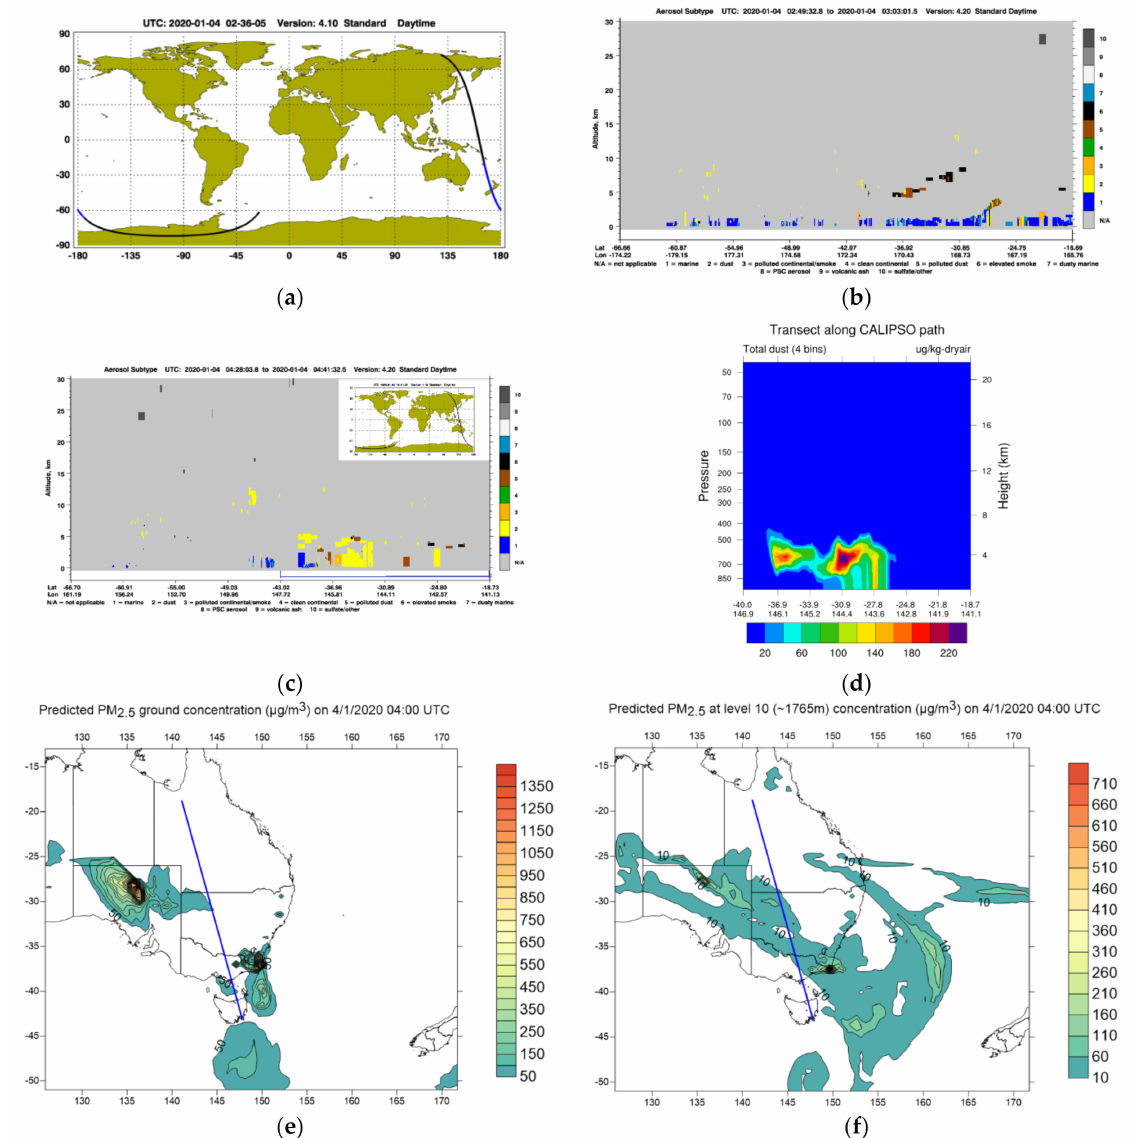
Figure 6. CALIPSO satellite path ( a ) and aerosol profile ( b ) over the Coral Sea and New Zealand on 4 January 2020 at 2:36 UTC. The CALIPSO aerosol profile ( c ) and WRF-Chem prediction of transect of dust along the satellite path ( d ) and spatial distribution of PM 2.5 concentration at the ground ( e ) and the height ~1765 m ( f ) on 4 January 2020, 4:00 UTC. CALIPSO aerosol profile identifies 10 aerosol subtypes: marine, dust, polluted continental/smoke, clean continental, polluted dust, elevated smoke, dusty marine, PSC (polar stratospheric cloud) aerosols, volcanic ash and sulfate/others. With low soil moisture, high temperature and low humidity, the risk of fires